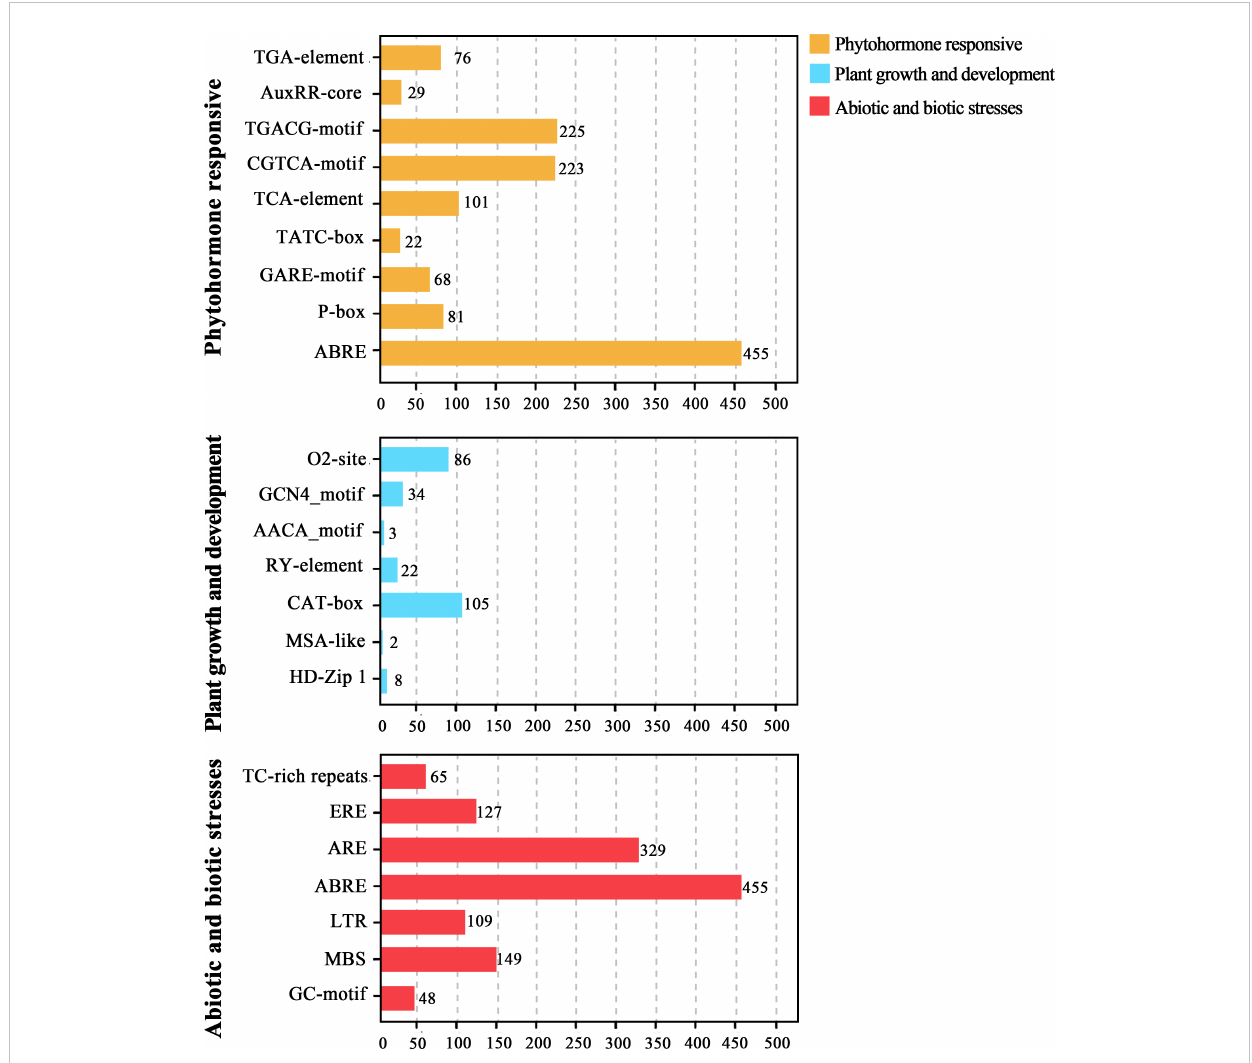
FIGURE 6 Gene ontology (GO) distribution of CpbHLH proteins. GO annotation using a cut-off value of p ≤ 0.05 showed that GO items including molecular function (MF), biological process (BP), and cellular component (CC), while predominant GO items was selected to visualize the